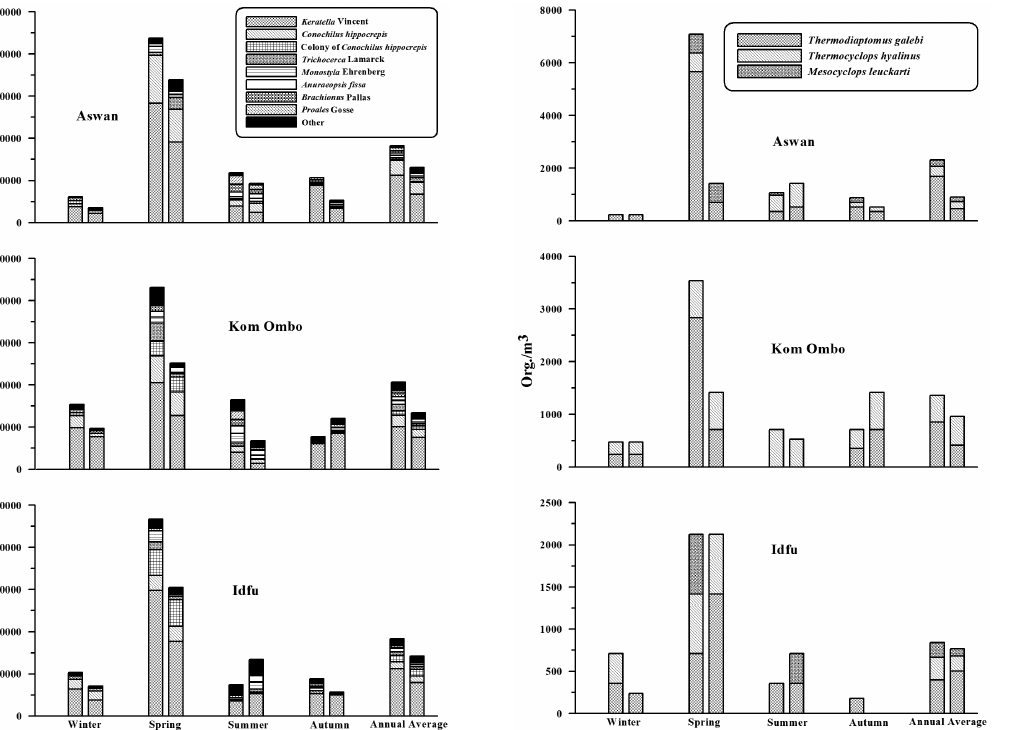
Figure 10. Distribution and seasonal variations of Rotifera in the River Nile. Left bar (upstream) and right bar (Downstream).